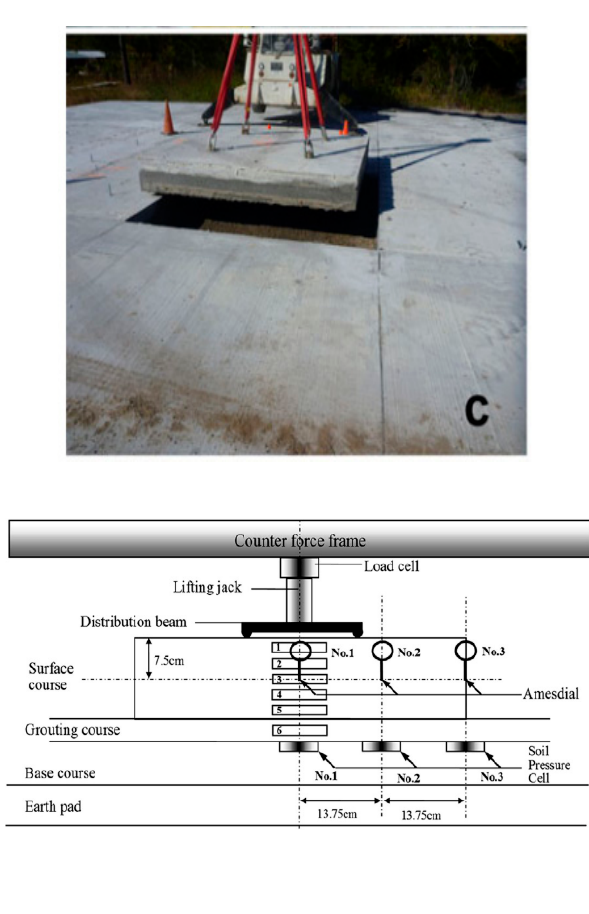
Figure 13. Laboratory test [49–52].